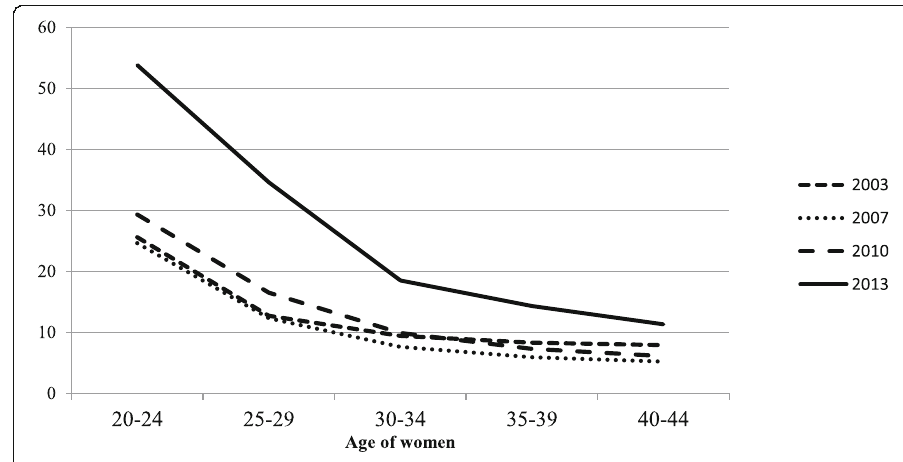
Fig. 8 The Philippines: percentage of women currently cohabiting among women currently in a union (married or cohabitating) by age. Sources: Philippines 2003 and 2007 survey data; 2010 census, United